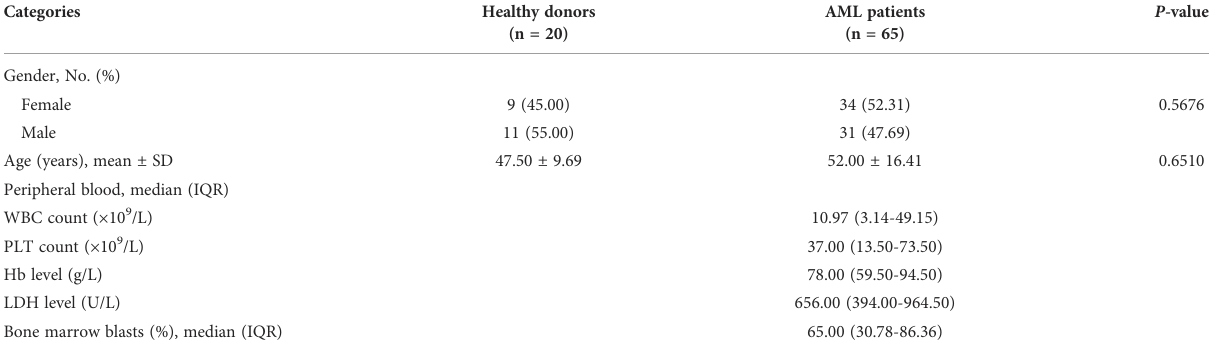
TABLE 1 Clinical characteristics of study